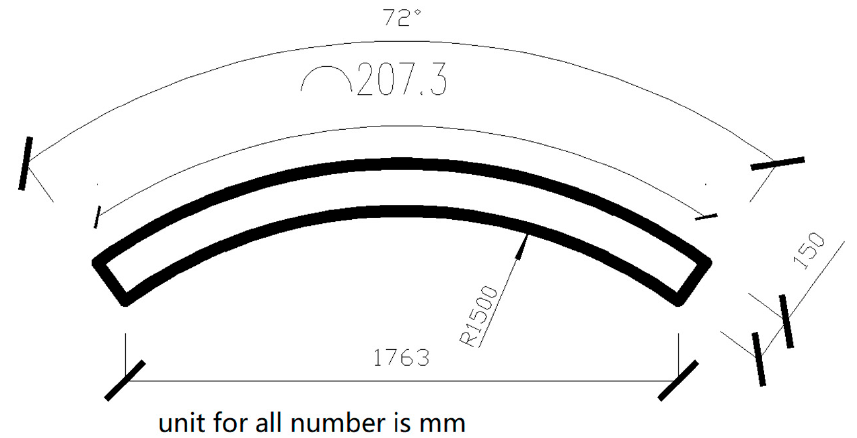
Figure 1. The detail size of the concrete lining structure. Due to the long and narrow special structure of tunnels, the current research on the temperature field of tunnels mostly focuses on the high-temperature area of the arch crown and its longitudinal heat attenuation. However, there are few temperature tests on the vertical cross sections of the tunnel lining structure. For the core damage area, the uneven temperature on the cross section of the tunnel will cause high-temperature stress and eventually lead to structural instability and failure. In order to monitor the temperature distribution at different parts of the concrete lining arch, thermocouples were embedded in advance (shown in Figure 3). 4 pieces of full size concrete lining structure were hoist and sealed over the top of the open-hearth furnace (Figure 4). In this way, the temperatures of different parts and different levels of concrete can be monitored during the process of the combustion